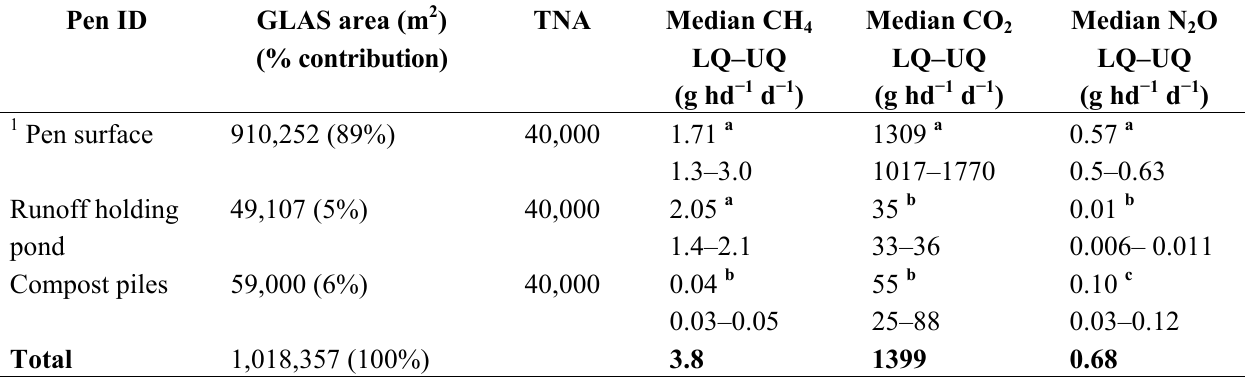
Table 5. Estimated emission rates (median and quartiles) from various GLASs at of the feedyard using pooled